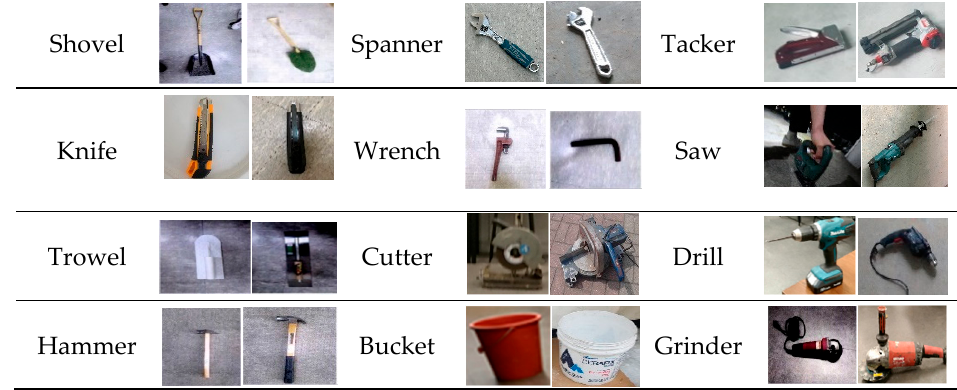
Figure 8. Models of small and medium-sized construction tools.